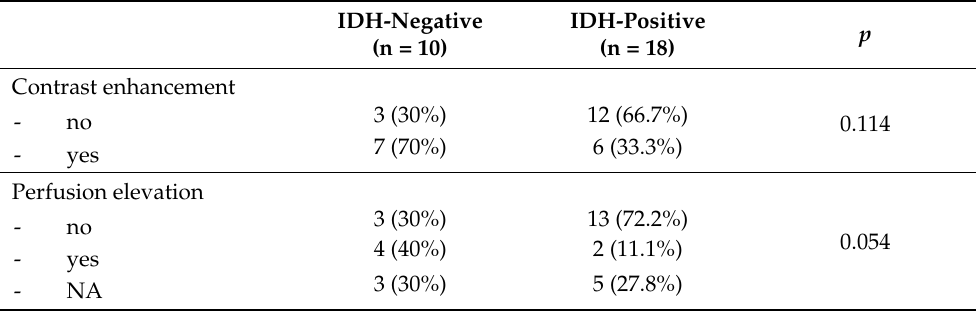
Figure 6. IDH mutation versus TBRmax. Table 4. The association of IDH mutational status with the evaluated contrast enhancement and perfusion elevation (Fisher’s exact